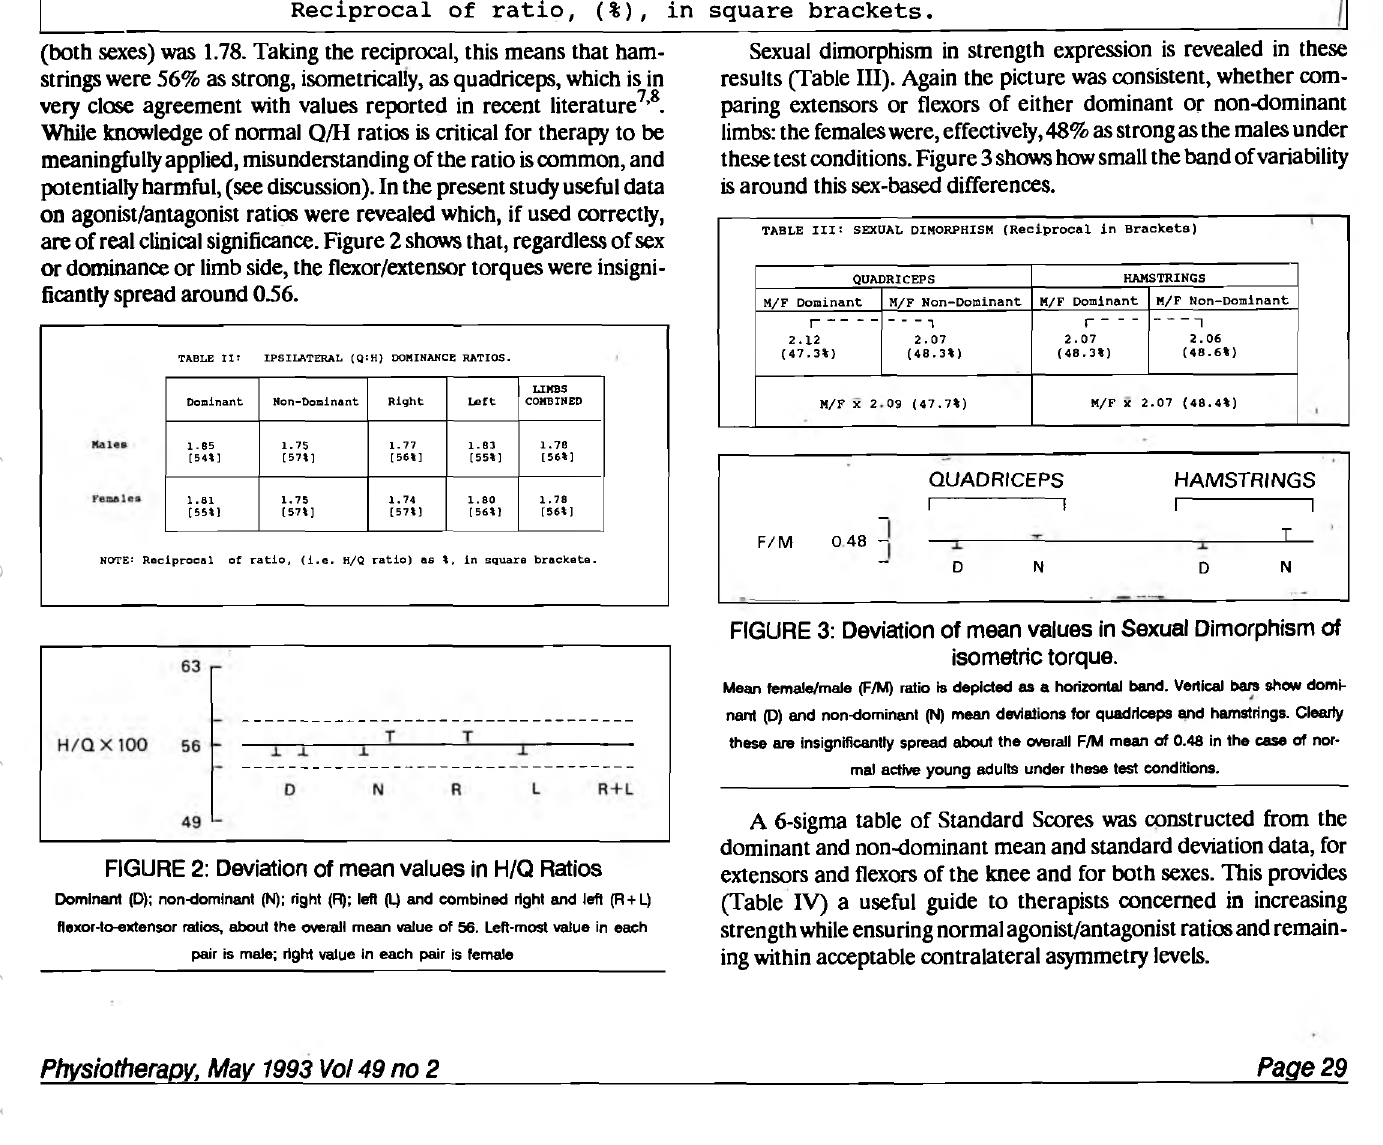
IPSILATERAL (Q:H) DOMINANCE RATIOS.